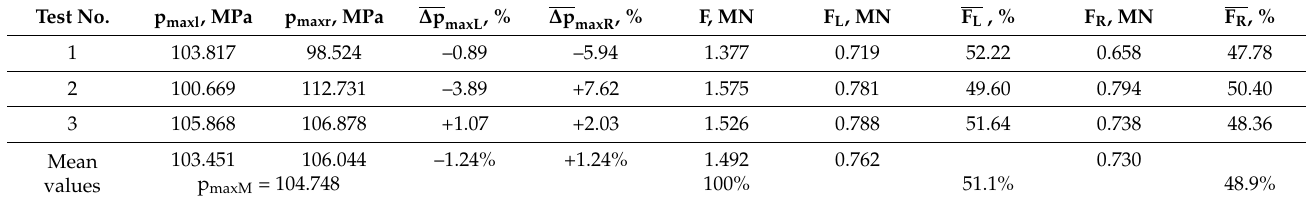
Table 1. Pressure and force parameters for two zones loaded by direct shock